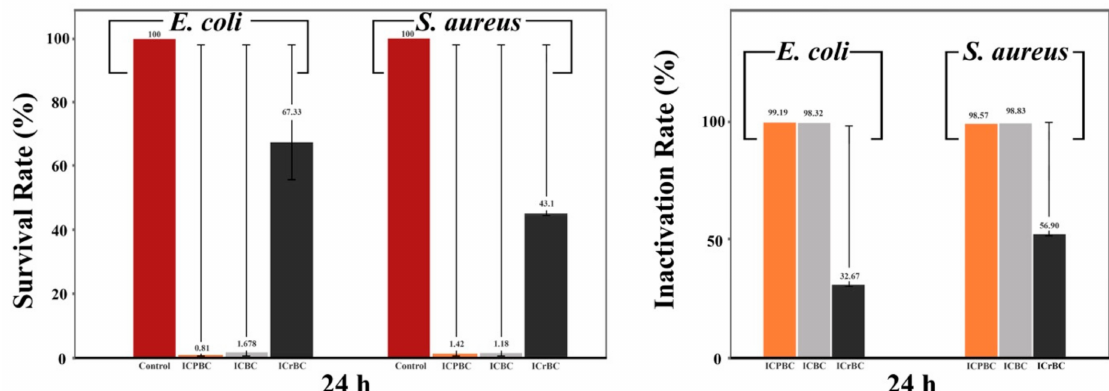
Figure 7. Survival and inactivation rates (%) of the membranes against E. coli and S. aureus .